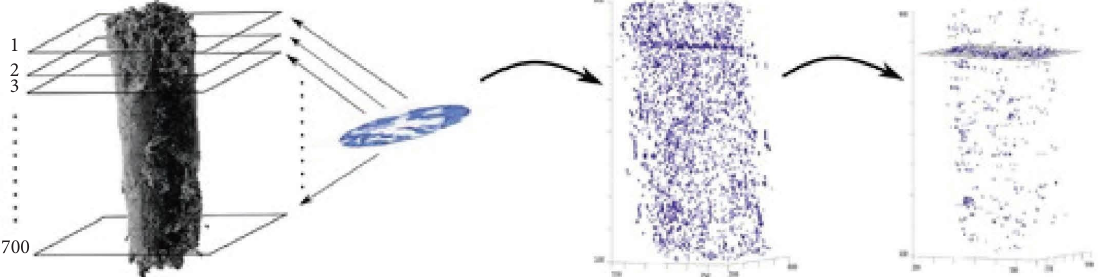
Figure 5: Exemplary workfow of a feature-based approach by Chicherova et al. [20] based on data originating from extracted human jawbones [29]. First, SURF-feature points (blue dots) were detected in all 700 planes of the CT scan and the histological image (left). Tese descriptors were then compared in a higher-dimensional space (middle). Matching descriptors of both modalities form a plane that was used as a basis to estimate the position of the histological section in the CT volume (right). Te plane was then further optimized by utilizing RANSAC (right). Reprinted by permission from Springer Nature customer service center GmbH: patch-based techniques in medical imaging. Patch-MI 2017. Lecture notes in Computer Science, vol 10530, Histology to μ CTdata matching using landmarks and a density-biased RANSAC, Chicherova, N., Fundana, K., M¨uller, B., Cattin, P.C., Copyright© 2014 springer in- ternational publishing